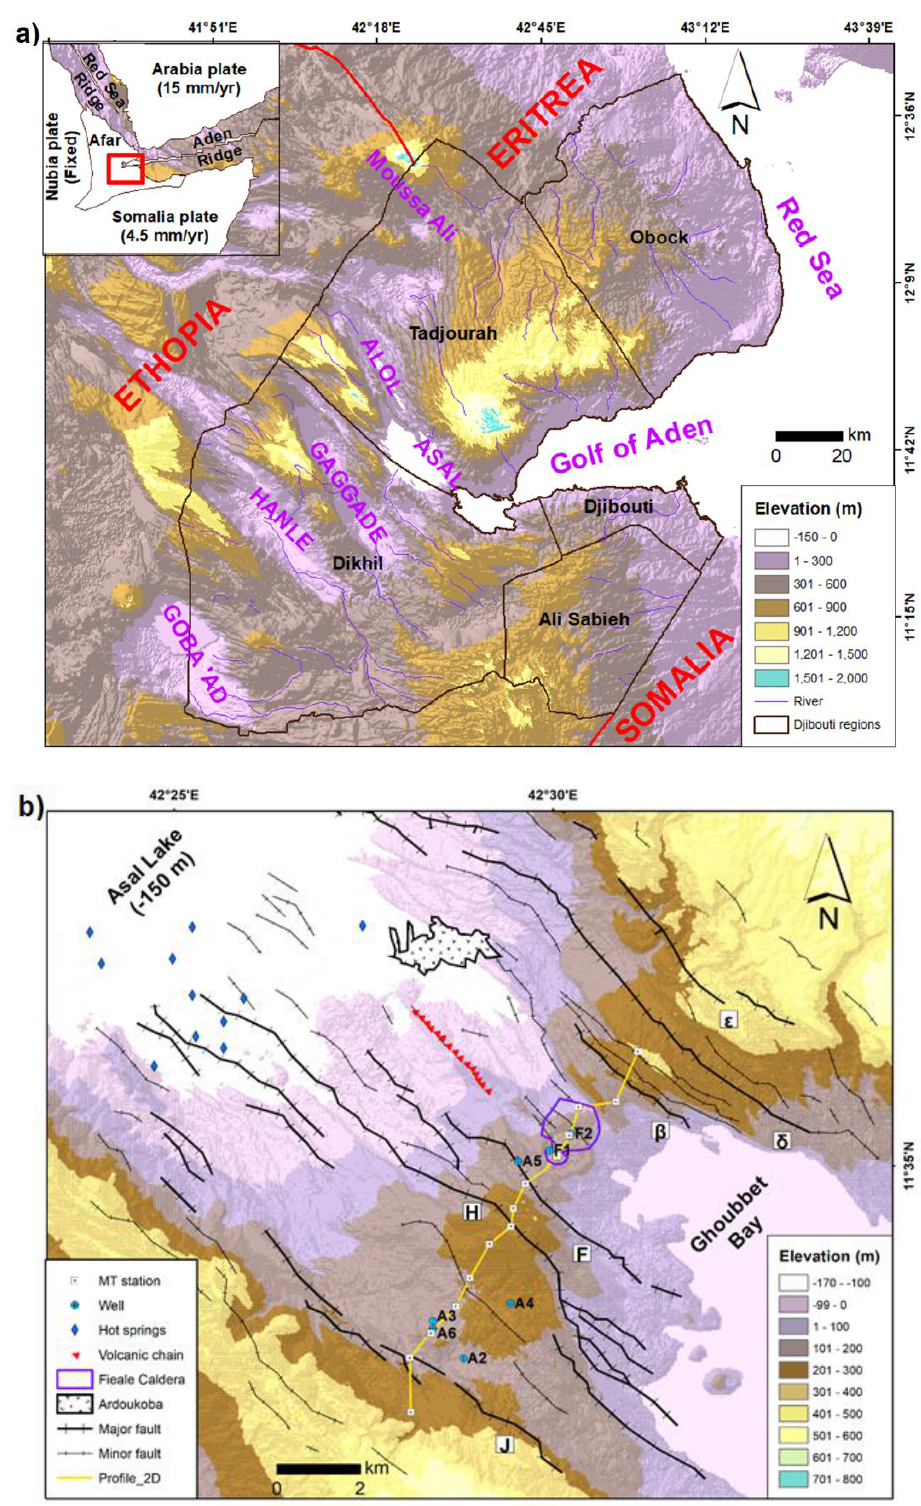
Figure 1. Topography and main structural elements of ( a ) Djibouti and ( b ) Asal rift. The red rectangle is Djibouti. MT abbreviates magnetotelluric modified from [13]. Recorded seismicity and inferred fault activity is concentrated at the surface and the areas surrounding the Fieale Caldera. Such activities are evidence that a central volcanic system can exist below the Fieale Caldera [11,12,19]. An intense seismic swarm